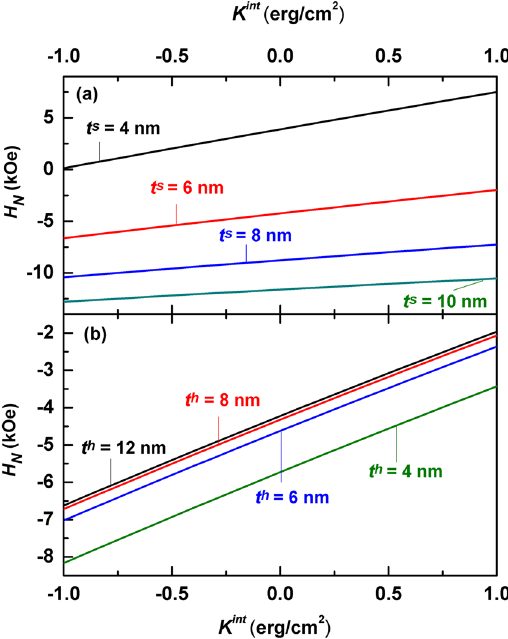
Figure 2. Calculated nucleation field as a function of the interface anisotropy constant K int based on Eq. (10) for Nd 2 Fe 14 B/ α -Fe multilayers. ( a ) Nucleation fields for various soft layer thickness at t h = 10 nm. ( b ) Nucleation fields for various hard layer thickness at t s = 6